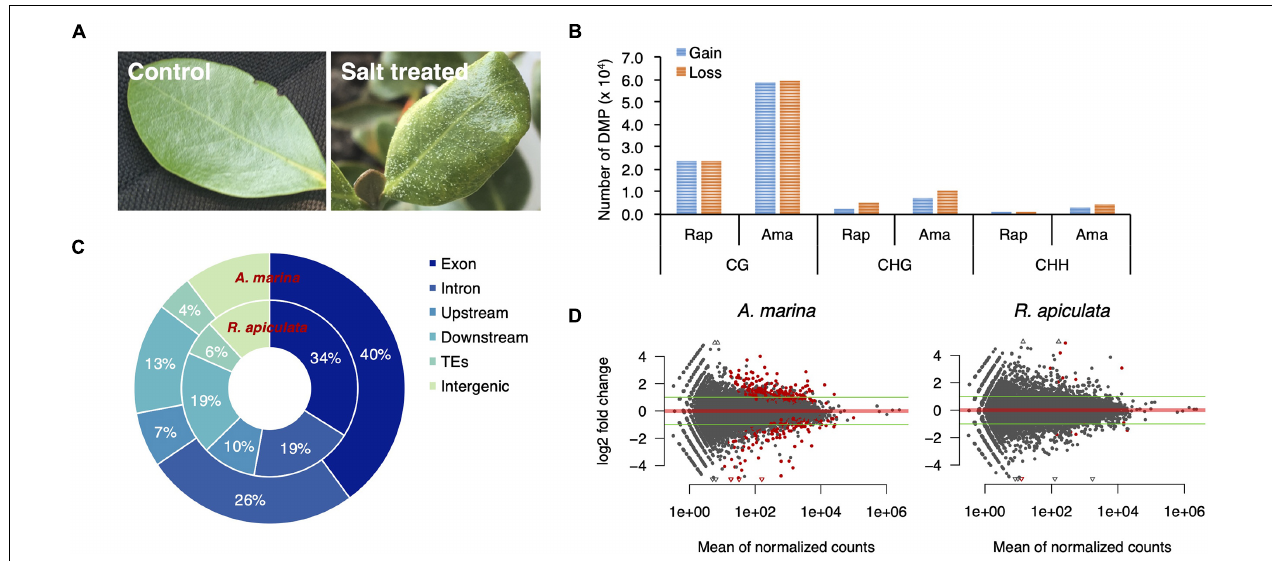
FIGURE 4 | Salt-induced changes of DNA methylation and gene expression in A. marina and R. apiculata . (A) Salt-treated and untreated leaves of A. marina . (B) The number of differentially methylated positions (DMPs) in response to salt treatment are shown by sequence context (i.e., CG, CHG and CHH, where H is A, T, or C). (C) The genomic distribution of CG-DMPs. (D) Fold changes of gene expression between salt-treated and untreated samples plotted against the averaged expression levels (the average of reads counts normalized by size factor) between them. The red points indicate genes with significant (Benjamini–Hochberg FDR < 0.05) differential expression.